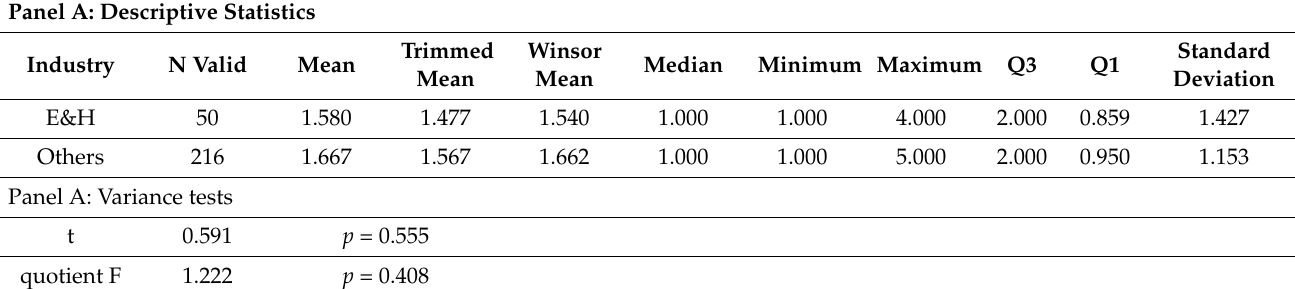
Table 8. Number of types of billing keys